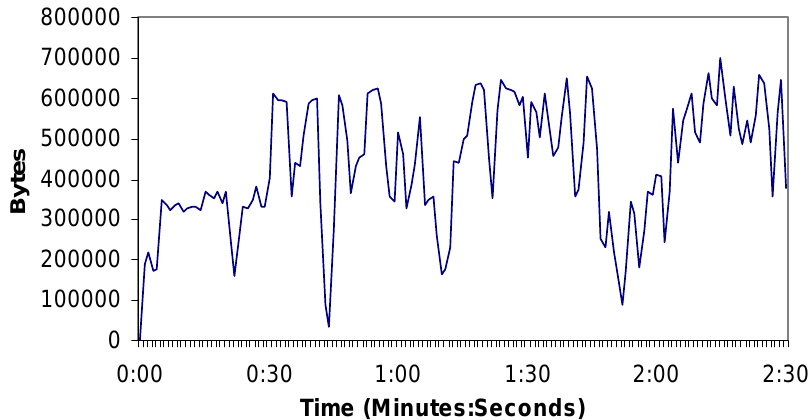
Figure 14. Bytes per second when there are four